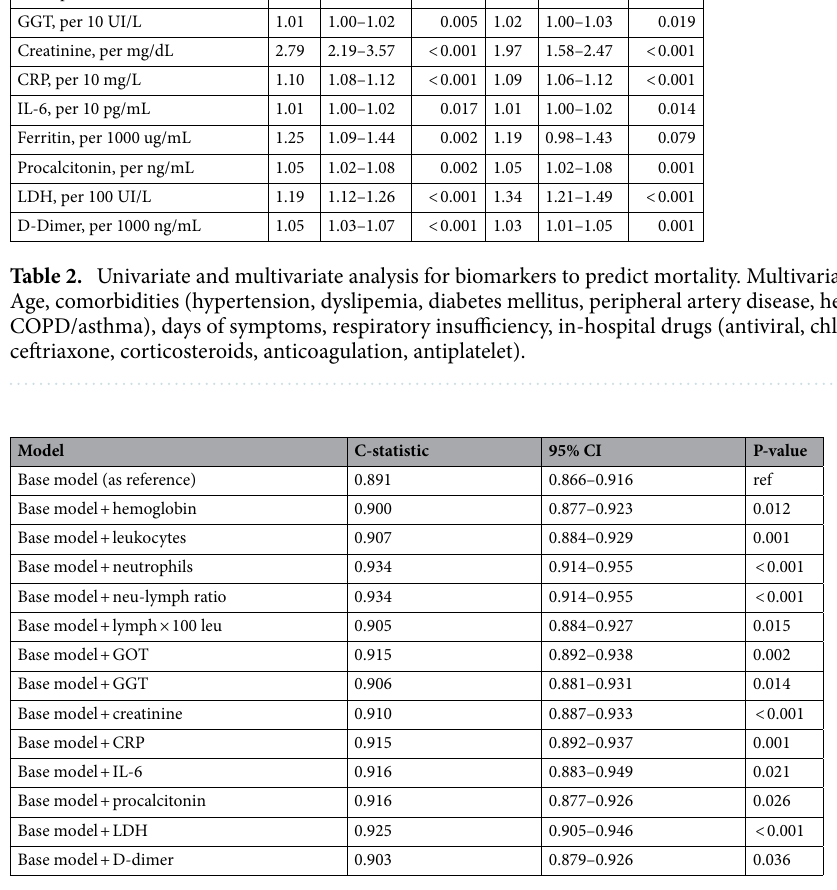
Table 3. Model performance to predict mortality basing on the addition of biomarkers. Model performance after the addition of different biomarker to the base model [age, comorbidities (hypertension, dyslipidemia, diabetes mellitus, peripheral artery disease, heart disease, COPD/asthma), days of symptoms, respiratory insufficiency, in-hospital drugs (antiviral, chloroquine, ceftriaxone, corticosteroids, anticoagulation,